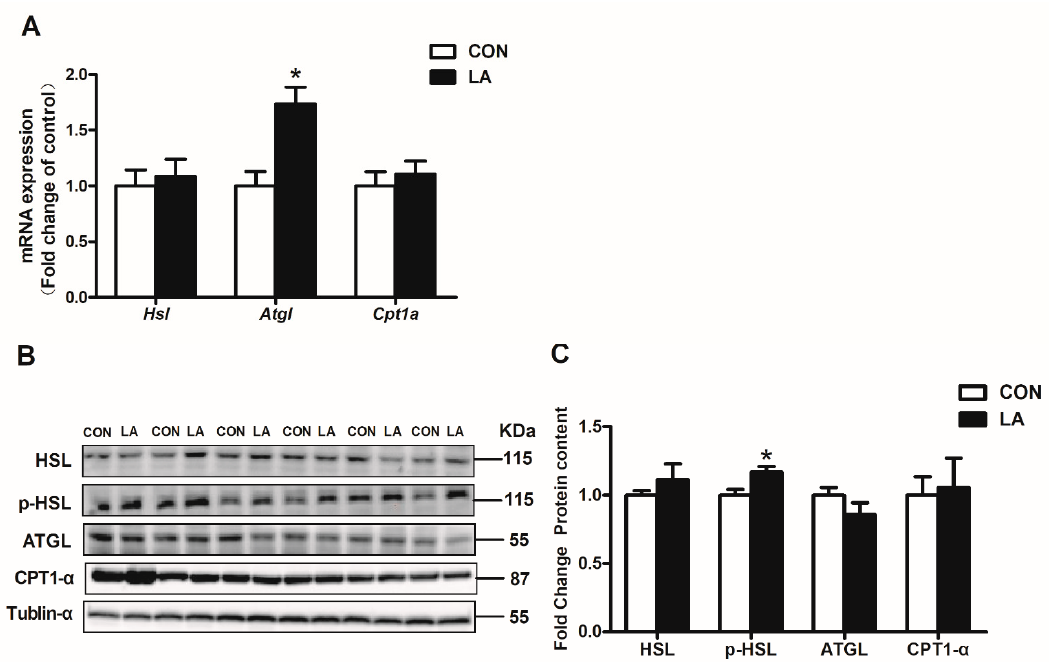
Figure 3. Relative hepatic lipolysis gene and protein expression. ( A ) qRT-PCR analysis of Hsl, Atgl, and Cpt1 α mRNA Figure 2. Relative hepatic lipid synthesis gene and protein expression. ( A ) Fasn, Acc, Acsl1, Acss1, Scd, Ppar- γ , Srebp1, expression. ( B ) HSL, p-HSL, ATGL, CPT1 α , and tubulin- α protein levels were evaluated by Western blotting. ( C ) Densito- Nutrients 2021 , 13 , x FOR PEER REVIEW and Srebp2 mRNA expression were evaluated by qRT-PCR. ( B ) Western blot analyses of FASN, ACC, ACSL1, ACSS1, metric analysis of HSL, p-HSL, ATGL, and CPT1- α protein expression. CON: Control diet, LA: Control diet+ alpha-lipoic SCD, PPAR- γ , SREBP1, and tubulin- α proteins. ( C ) Densitometric analysis of FASN, ACC, ACSL1, ACSS1, SCD, PPAR- γ , and SREBP1 protein levels. CON: C on trol diet, LA: Control diet+ alpha-lipoic acid. Values are expressed as mean ± SEM, acid.Values are expressed as mean ± SEM, n = 6 in each group, * p < 0.05. n = 6 in each group, * p < 0.05.